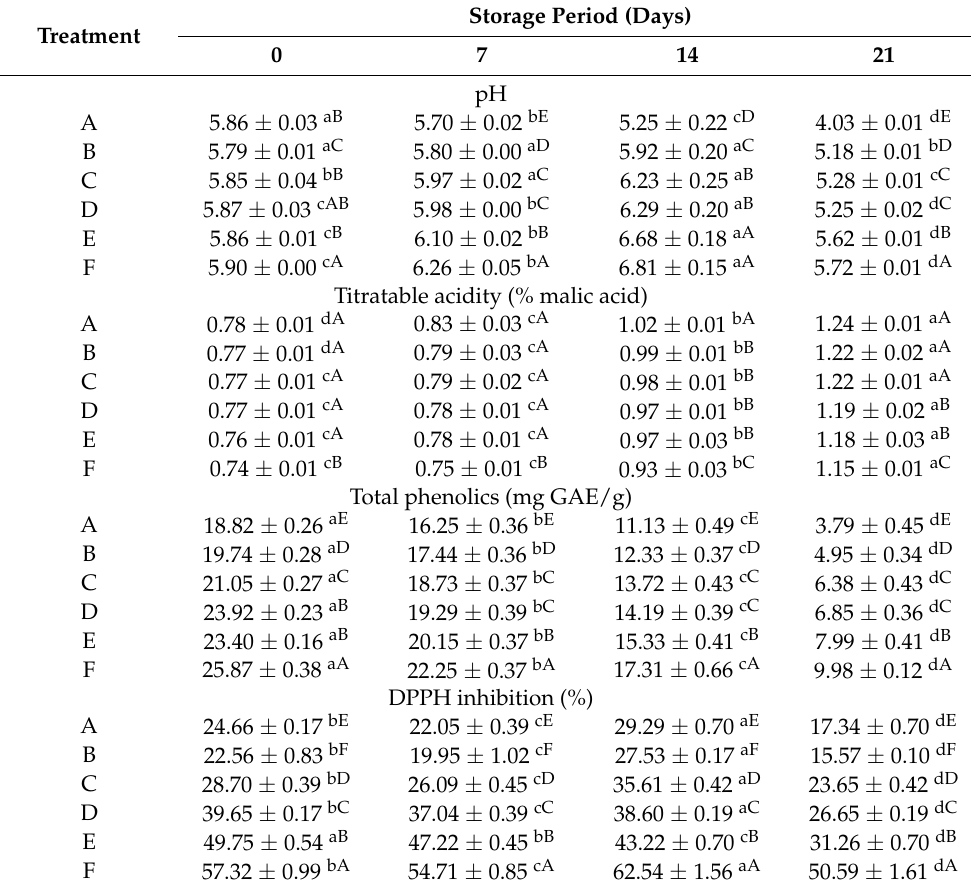
Table 2. Changes in pH, acidity, total phenolics, and antioxidant activity of fresh cucumber coated with chitosan and/or olive cake extract (OCE) or orange peel extract (OPE) during cold storage (4 ◦ C).